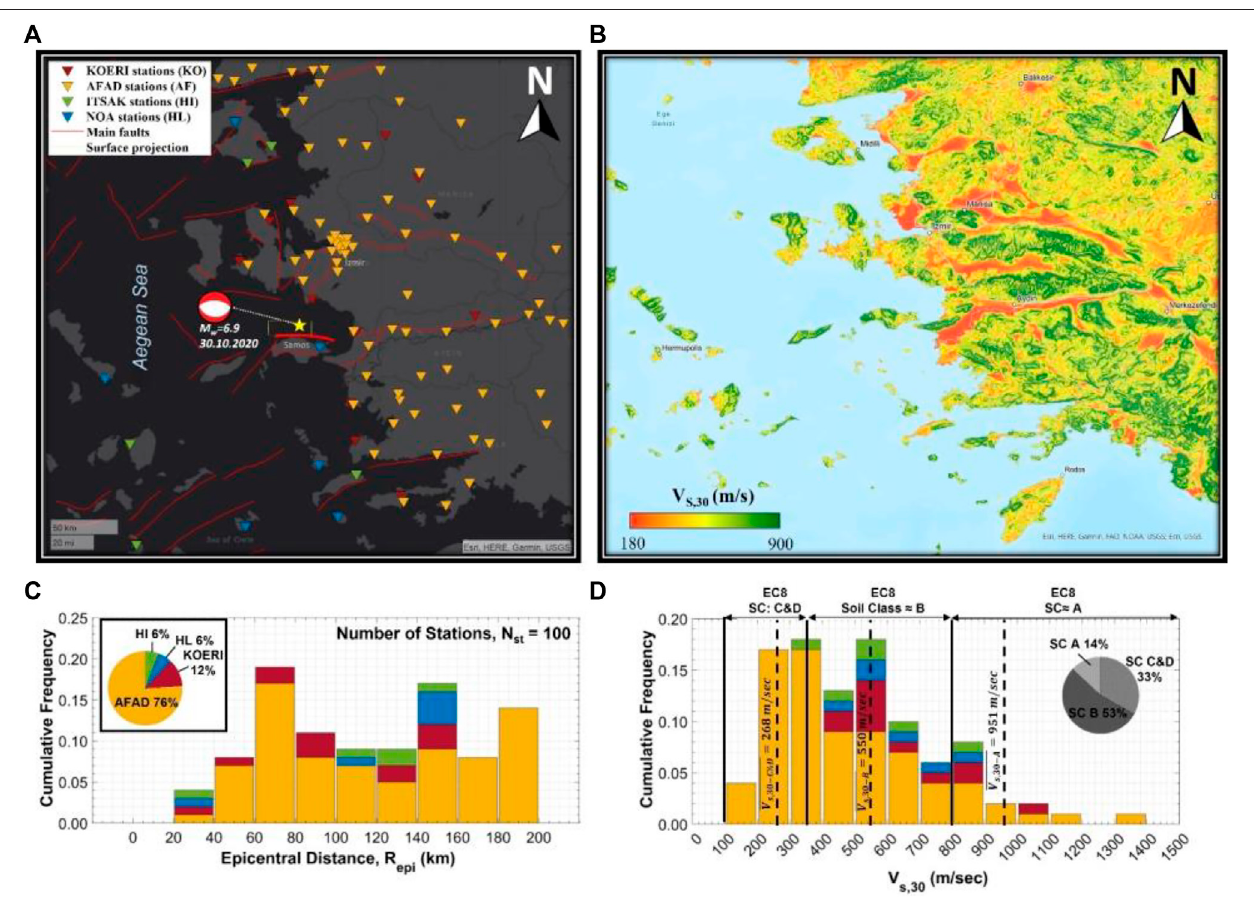
FIGURE 6 | (A) Spatial distribution of network-based strong ground motion stations recording the 30.10.2020 M W 6.9 Aegean Sea earthquake within 200 km of epicentral distances, (B) USGS topography-based average shear wave velocity (V S30 ) distribution of the region, (C) The statistical distribution of epicentral distances of stations (D) The statistical distribution of V S30 values of stations (herein, it is considered the V S30 values provided by the networks instead of USGS topography-based values).